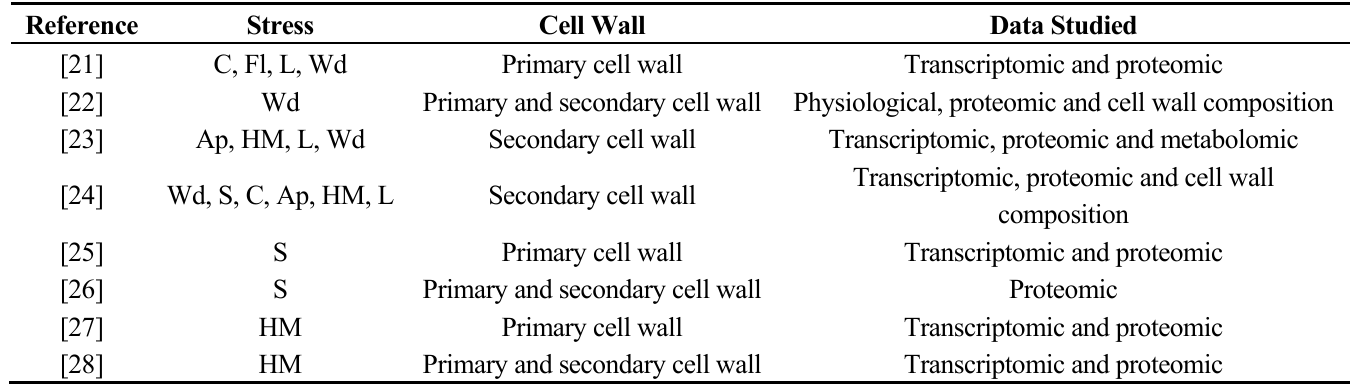
Table 1. List of references of recent reviews on the effects of abiotic stress on cell wall metabolism. References to the papers are given in